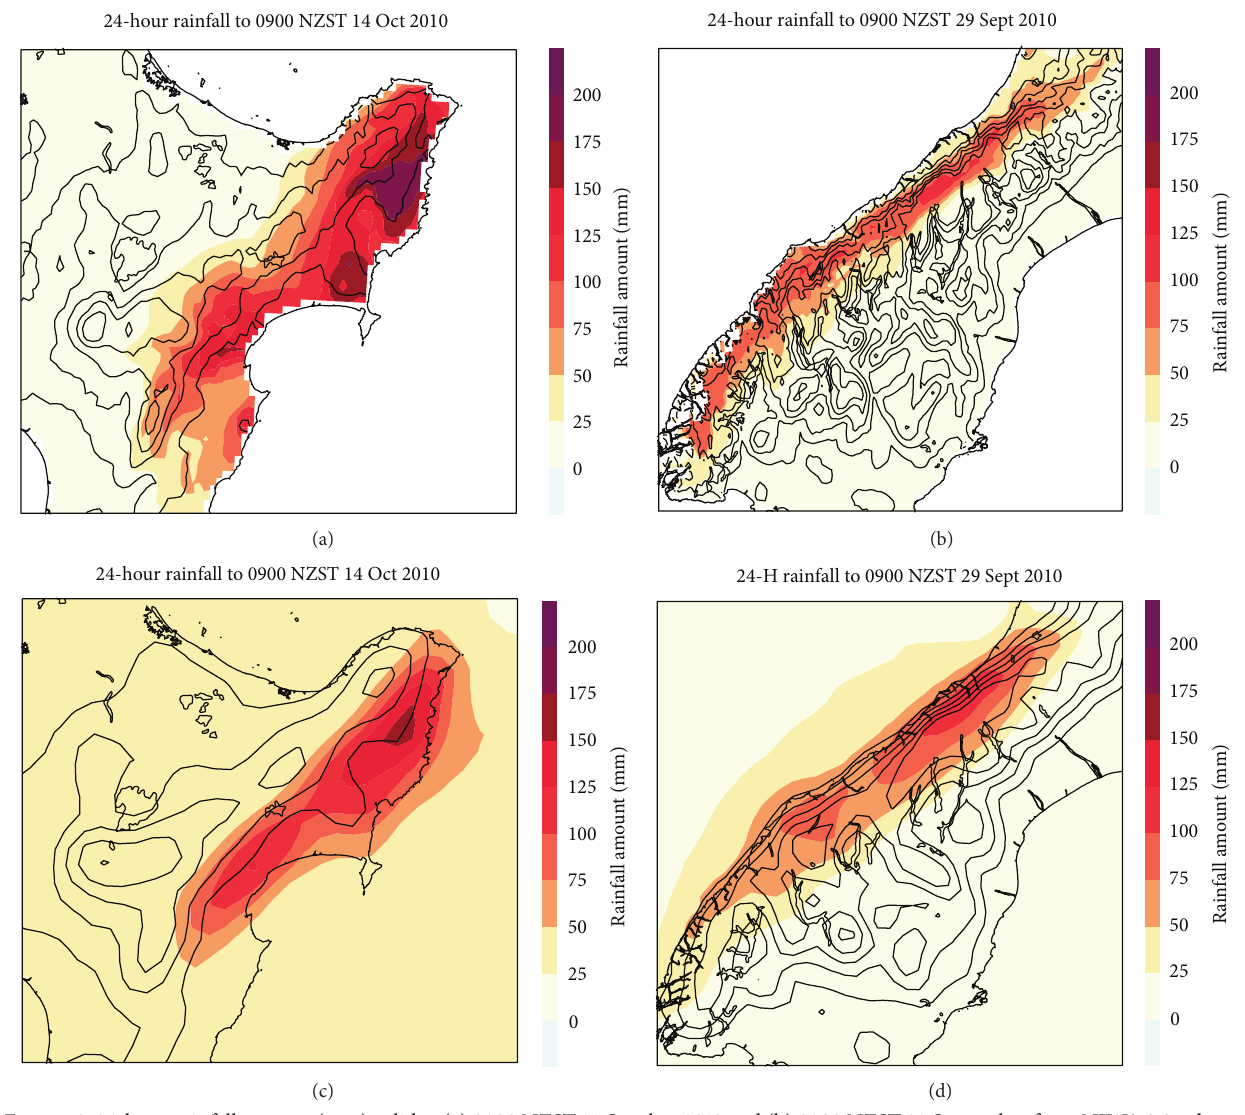
Figure 3: 24-hour rainfall amount (mm) valid at (a) 0900 NZST 14 October 2010 and (b) 0900 NZST 29 September from NIWA 0.05-degree grid point rainfall analysis. Simulated 24-hour rainfall amount valid at (c) 0900 NZST 14 October 2010 and (d) 0900 NZST 29 September from the ensemble mean (MM) forecasts with analysis at 0006 NZST. Thin solid lines denote terrain contours with a 250-meter